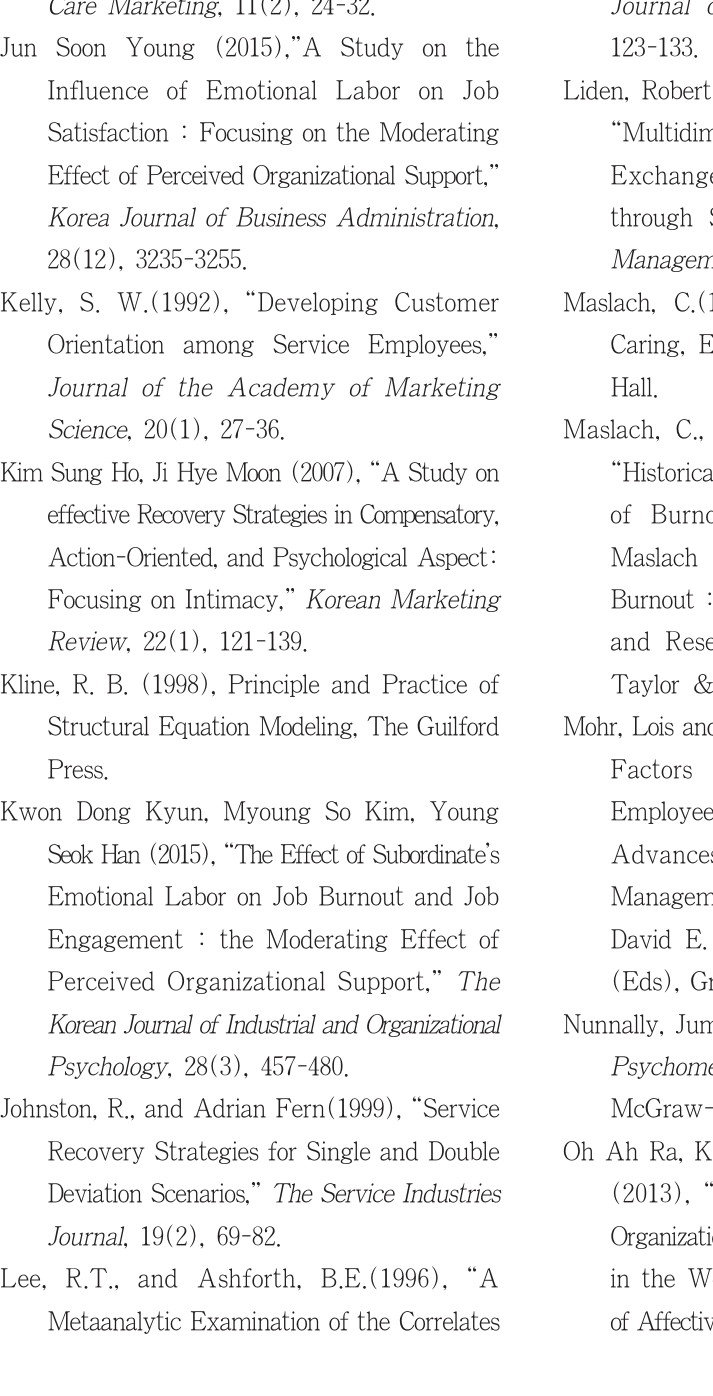
Customer-Contact Employee Support and Service Recovery Efforts: The Mediating Role of Job Burnout and Customer Orientation